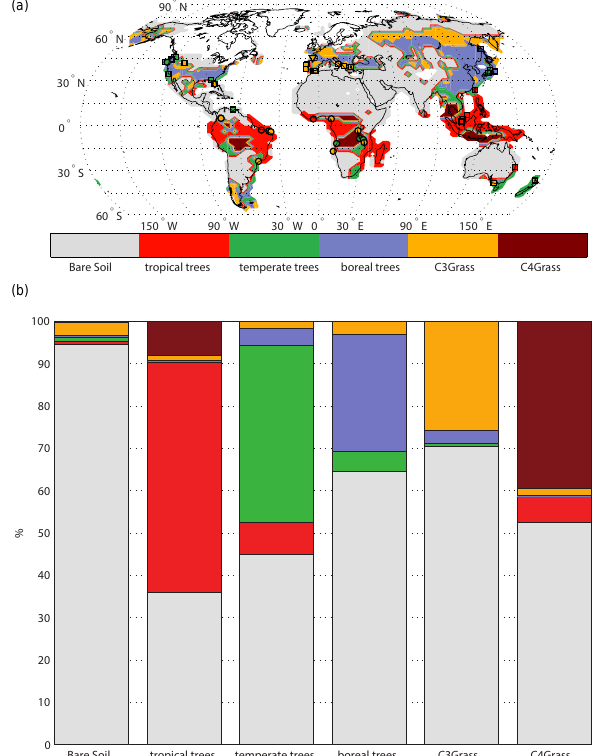
Figure 5. (a) Model–data comparison of mega-biome distribu- tion for LGM_ctrl based on dominant PFT type simulated by OR- CHIDEE. For each grid cell, the fraction of bare soil, tropical forests, temperate forests, boreal forests, and C3 and C4 grasses is considered. The type covering the greatest cell fraction is the dom- inant type. Note that dominant bare soil fraction denotes more than 80%. Circles denote LGM mega-biomes inferred from pollen and plant macrofossil records compiled by the BIOME6000 project. Re- fer to Table 4 to see how PFTs simulated by ORCHIDEE have been assigned to the mega-biomes mapped in this figure. (b) Detail of the averaged vegetation composition in grid cells occupied by a domi- nant mega-biome for LGM_ctrl.